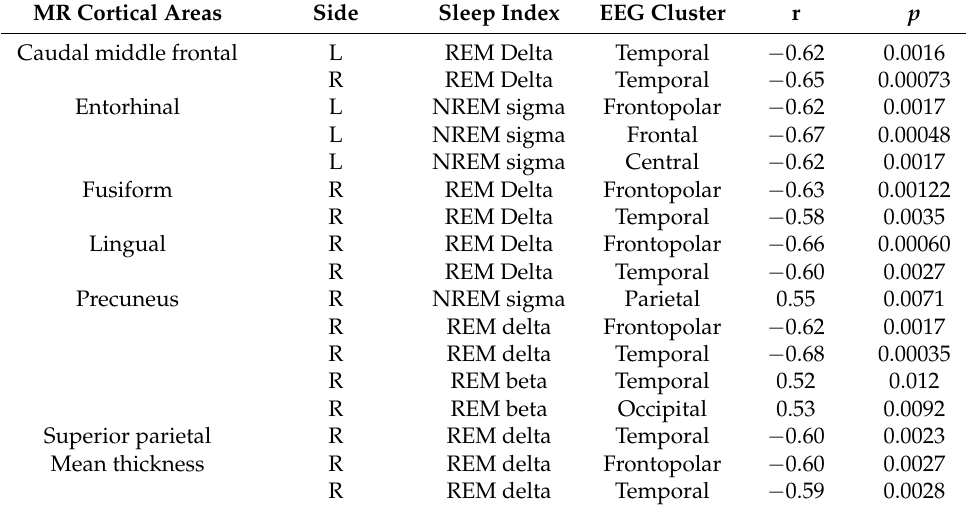
Table 2. Relationships between cortical thickness and sleep EEG alterations in AD. Significant (FDR- adjusted p ≤ 0.05) correlations between cortical thickness and sleep EEG alterations (NREM sigma power, REM delta and beta power) during sleep in AD. Pearson’s r coefficients and corresponding uncorrected p values are